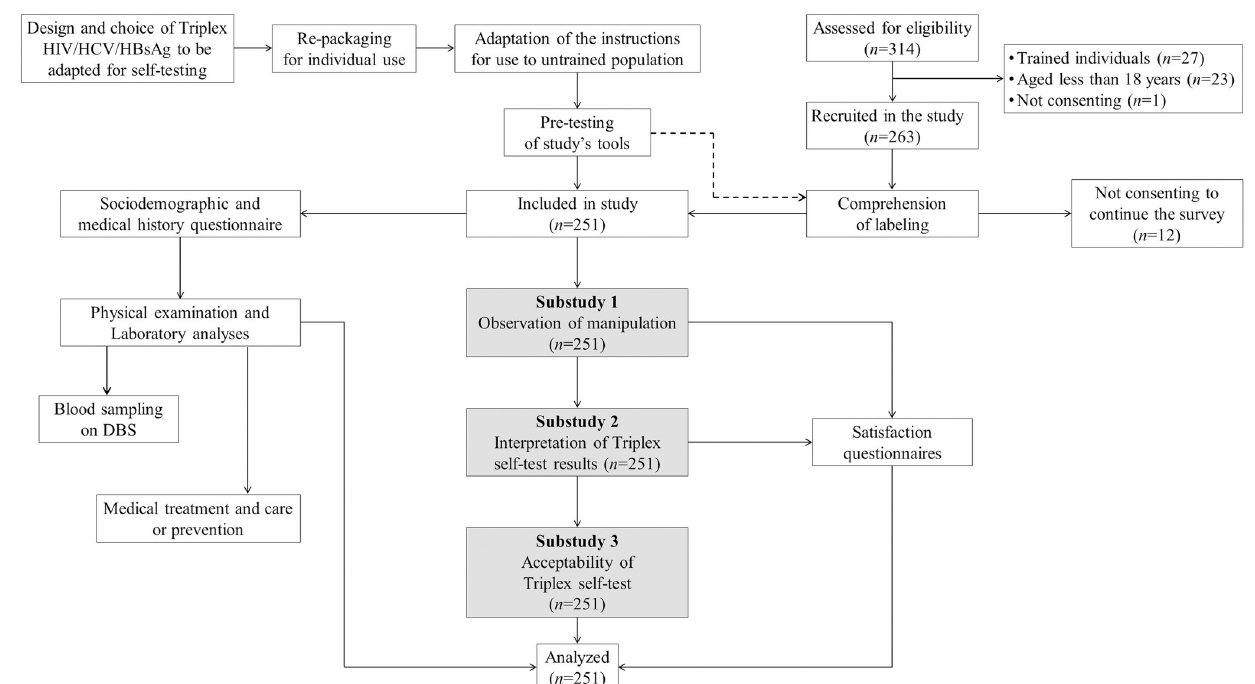
Fig 2. Flow chart showing the development of the Triplex HIV/HCV/HBsAg self-test, the recruitment of study participants, and their participation for each substudy. DBS: Dried blood